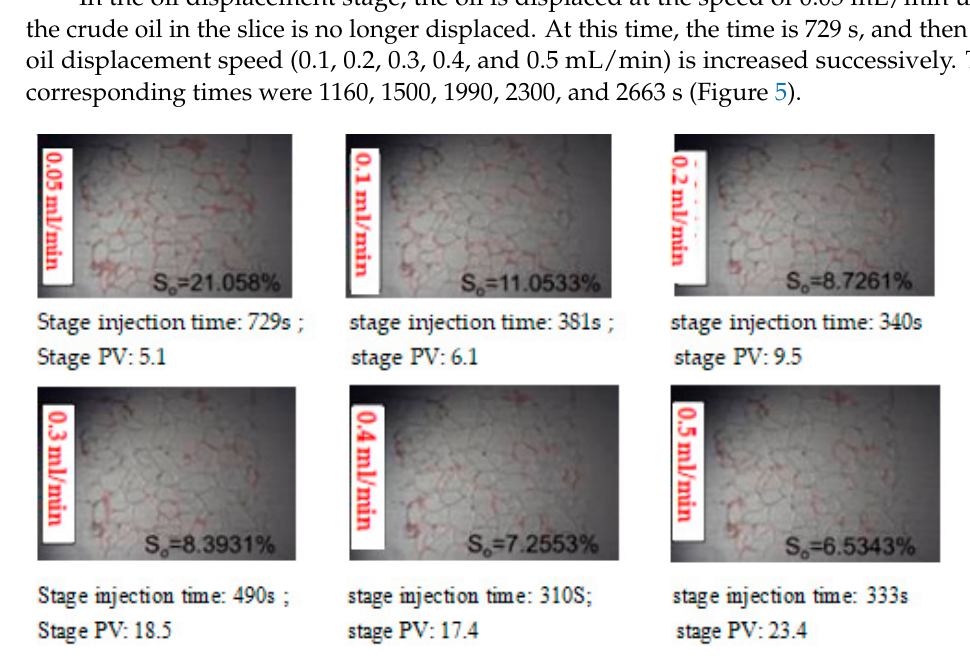
Figure 5. Experimental process of changing displacement rate and macroscopic displacement effect diagram.